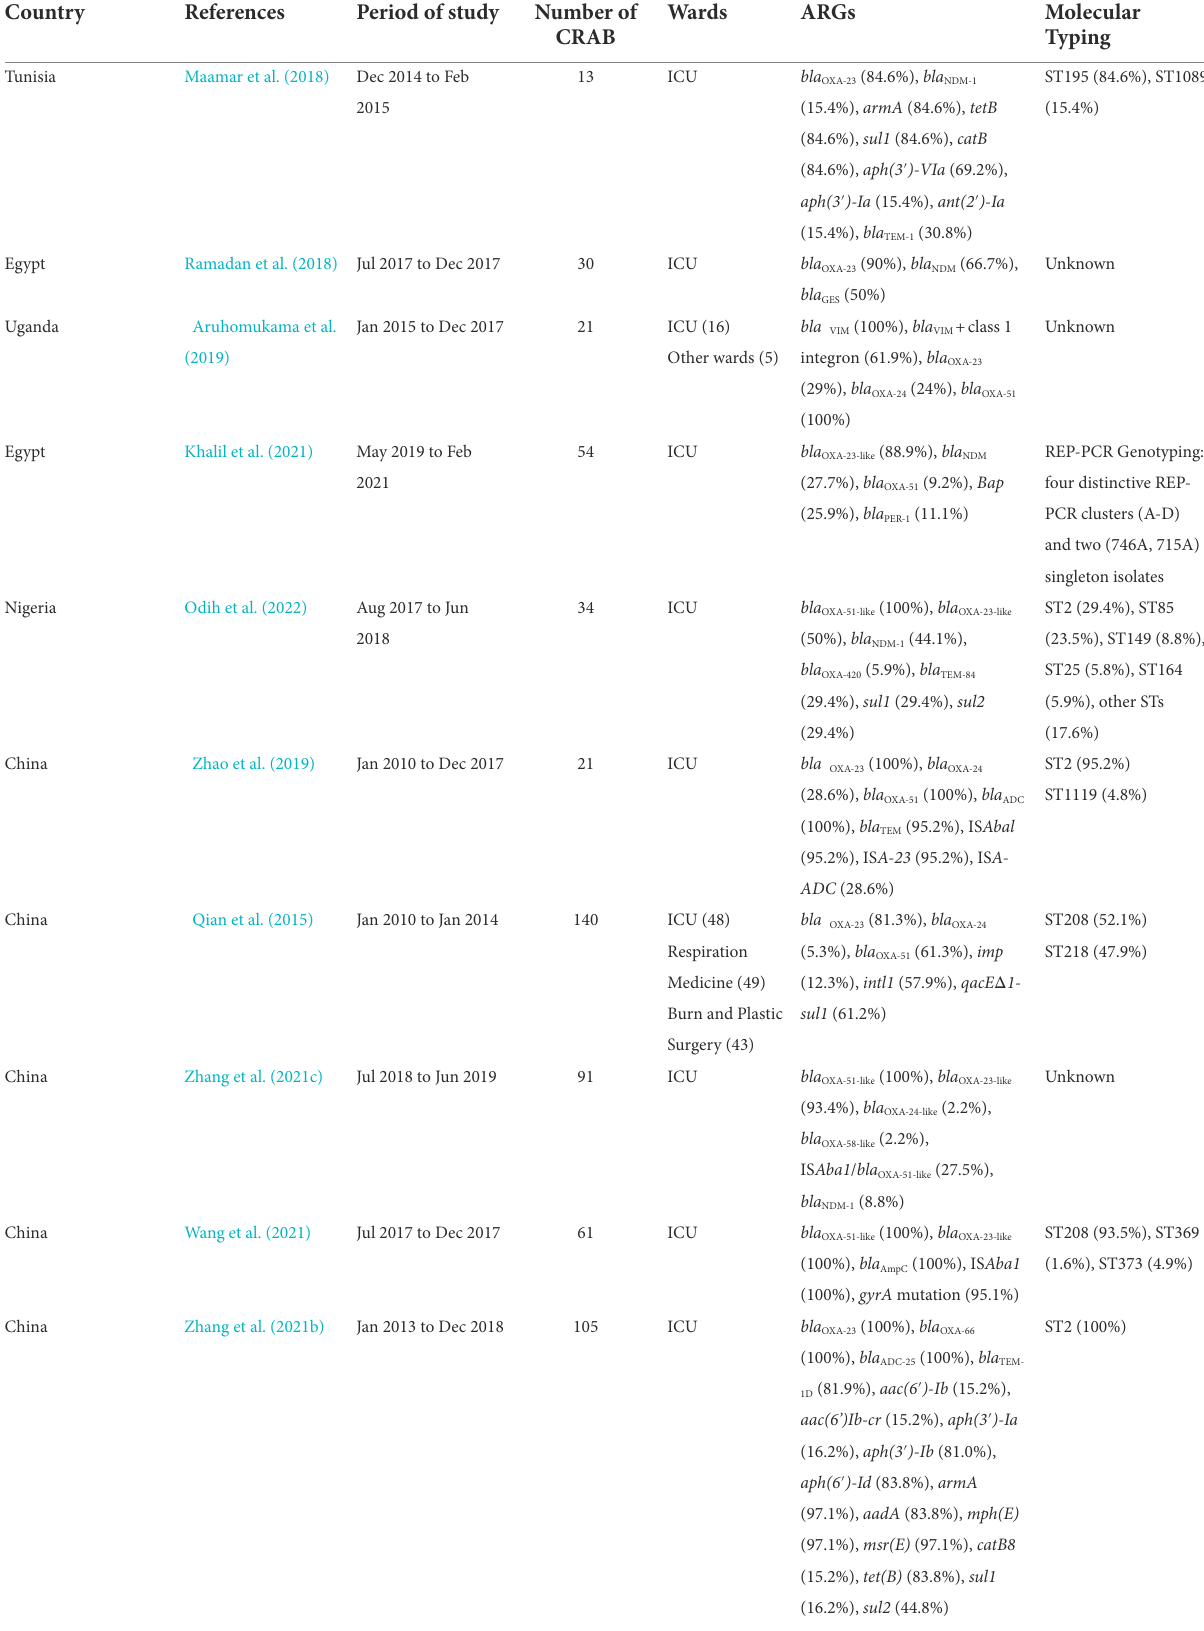
TABLE 1 Studies on CRAB and its ARGs isolated from ICU